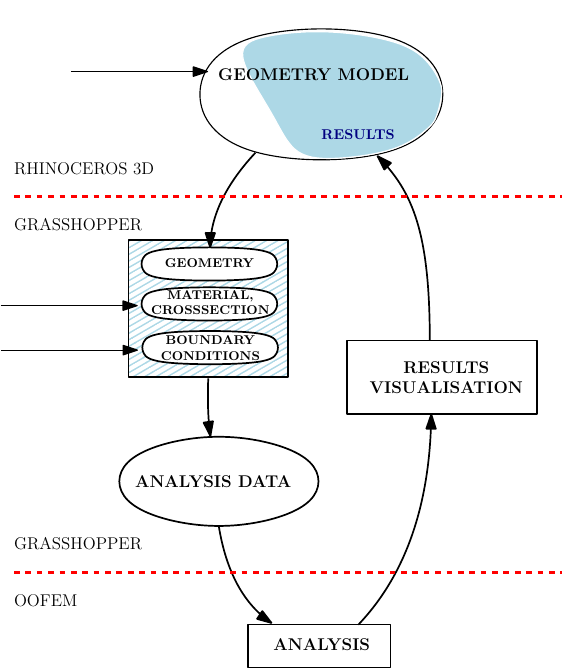
Figure 2. Interactive design